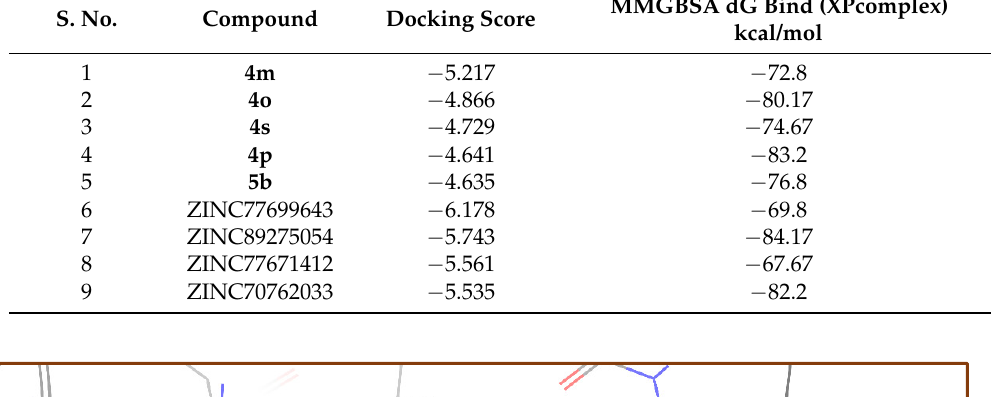
12 Figure 5. 3D-QSAR model (atom-based) consisting of ( A ) electron-withdrawing, ( B ) hydrogen bond donor, ( C ) positive ionic, ( D ) negative ionic, ( E ) hydrophobic groups, where the blue cubes showed positive coefficients and the red cubes showed negative coefficients.